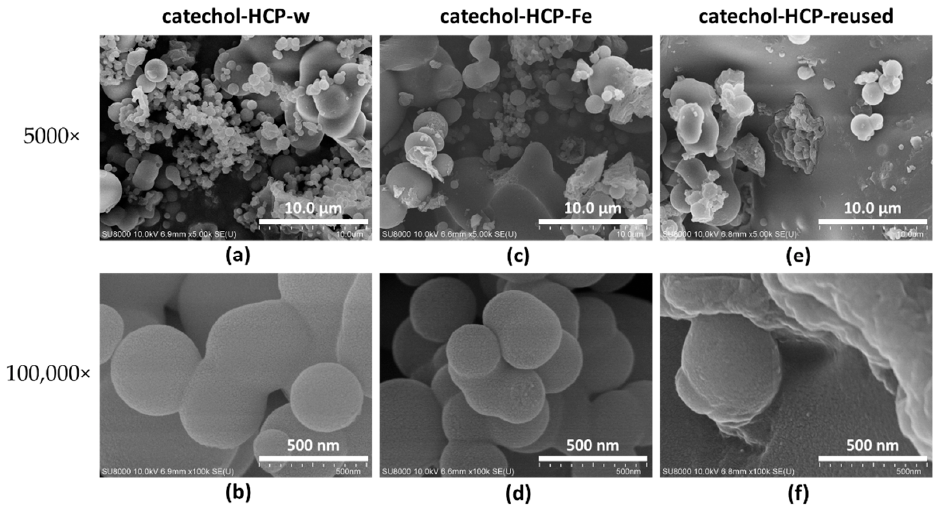
Figure 2. SEM images of catechol-HCP-w at ( a ) 5000 × and ( b ) 100,000 × ; catechol-HCP-Fe at ( c ) 5000 × and ( d ) 100,000 × ; and catechol-HCP-reused at ( e ) 5000 × and ( f ) 100,000 ×